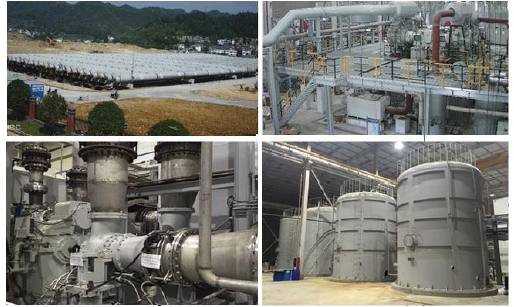
Figure 14. 10 MW AA-CAES pilot plant in China [60].